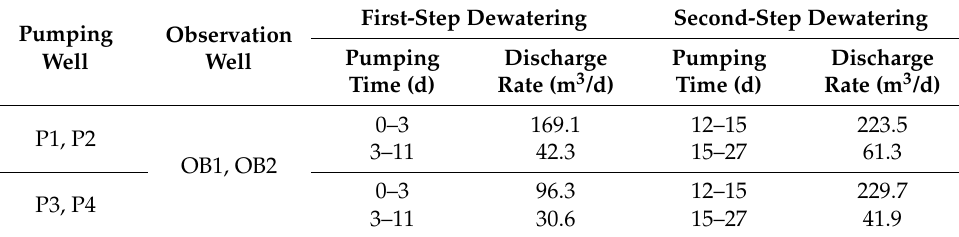
Figure 3. Structure and burial depth of wells and diaphragm wall. Table 1. Arrangement of pumping test.